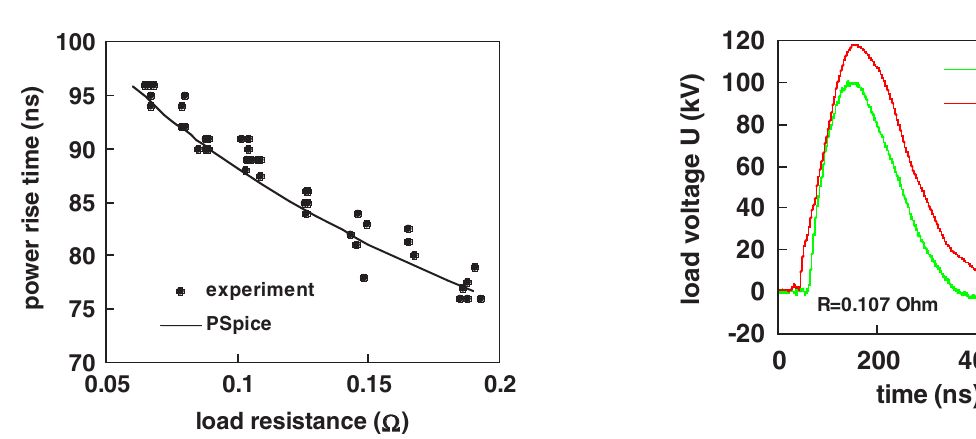
FIG. 7. (Color) Load voltage U and current around the core I C at R ¼ 0 : 107 Ohm . The volt-second integral VS LTD does not reach the maximum of VS P C ¼ 18 mVs . The current I C is approxi- mately proportional to the voltage U .